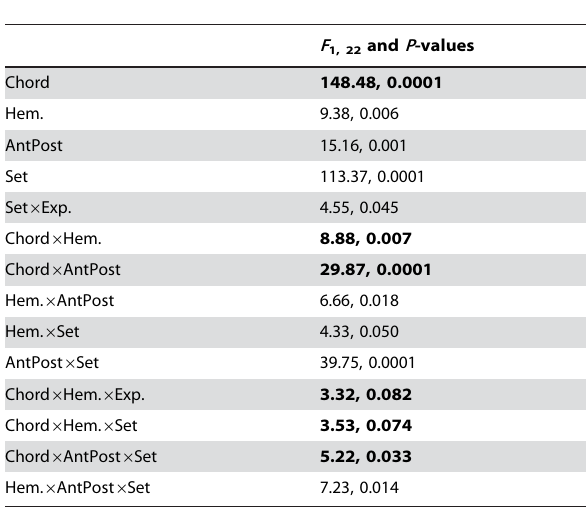
Table 1. Summary of global ANOVA for the ERAN time window (160–200 ms) with factors Chord (regular, irregular), Hemisphere (left, right), Anterior-Posterior (anterior, posterior), Set (A, B), and Expertise (nonmusicians,